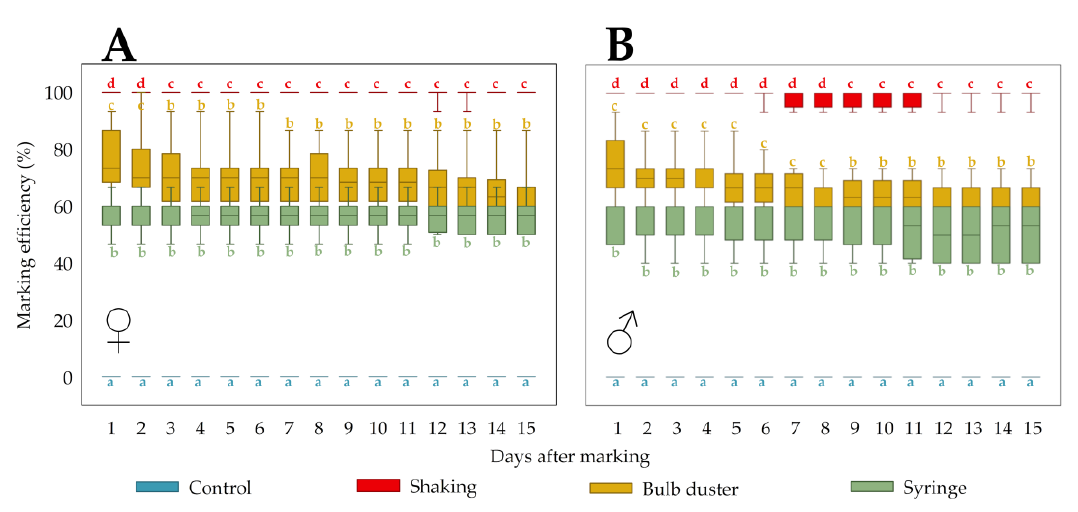
Figure 4. In order to evaluate marking efficiency and persistence of different application methods, the marks of individually kept D. suzukii flies were assessed daily. The marking efficiency (%) of each treatment (application techniques and control) is depicted by a box plot for each of the 15 observation days for females ( ♀) ( A ) and males ( ♂) ( B ). Different letters denote significant differences between treatments per observation day.